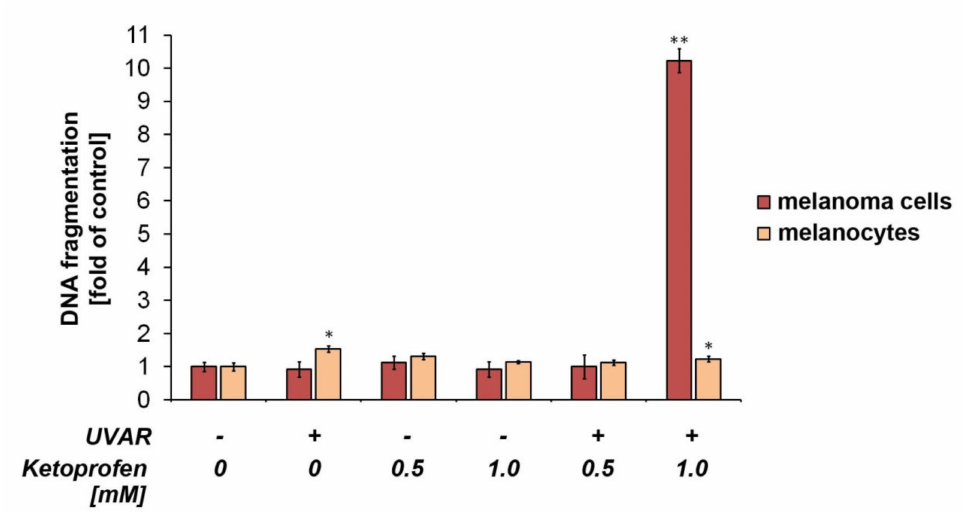
Figure 5. The impact of KTP and UVAR on DNA fragmentation in melanoma cells and melanocytes. Mean values of the percentage of cells with fragmented DNA and responding SD are shown as the bar graphic. * p < 0.05, ** p < 0.001 vs control (one-way ANOVA, two-way ANOVA, Tukey’s test).